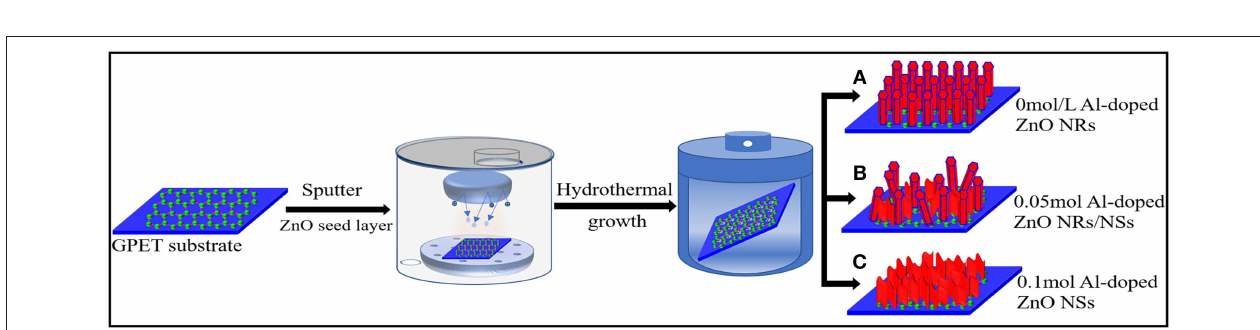
FIGURE 2 | Schematic diagram of hydrothermal growth mechanism of ZnO nanostructures.